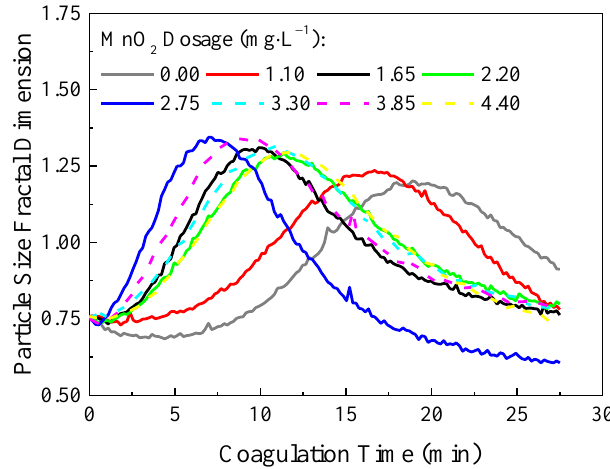
Figure 4. Change in the particle size fractal dimension with coagulation time.